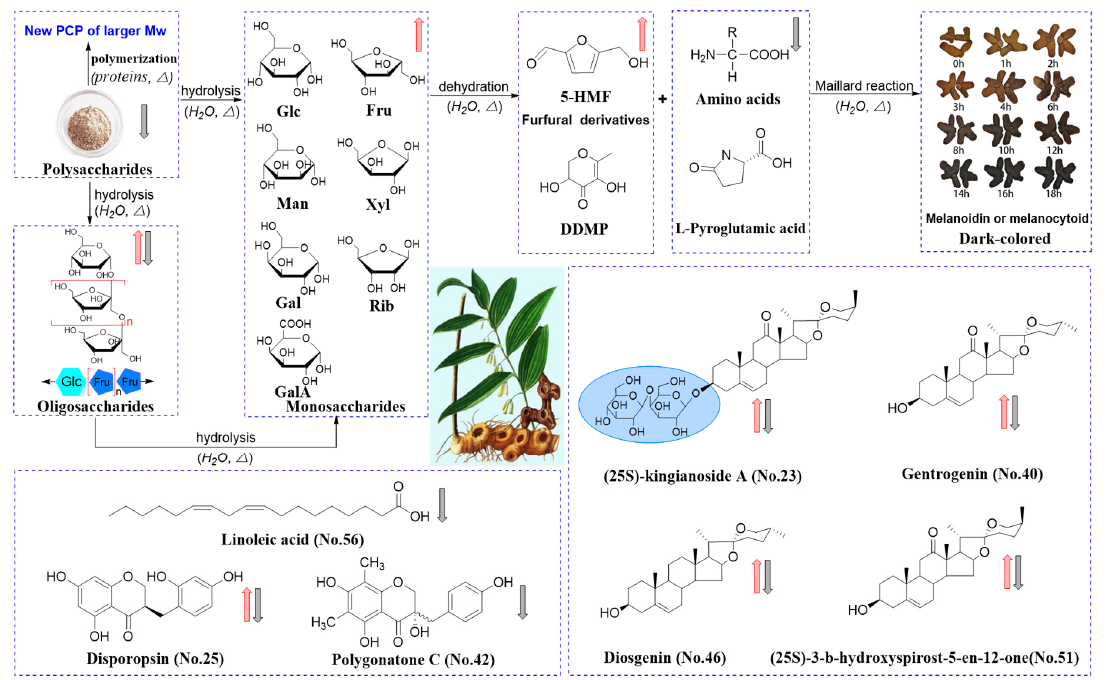
Figure 5. ( A ) Monosaccharide composition of PCP with varying processing times. ( B ) HPGPC-RID chromatograms of PCP with varying processing times. ( C ) The molar ratio of each monosaccharide to all monosaccharides. ( D ) Ratio of each PCP peak area to total PCP peak area. ( E ) Glycoprotein, uronic acid, and total polysaccharide content variations of PCP during processing. ( F ) Polysaccharide content variations of PCR medicinal materials during processing.